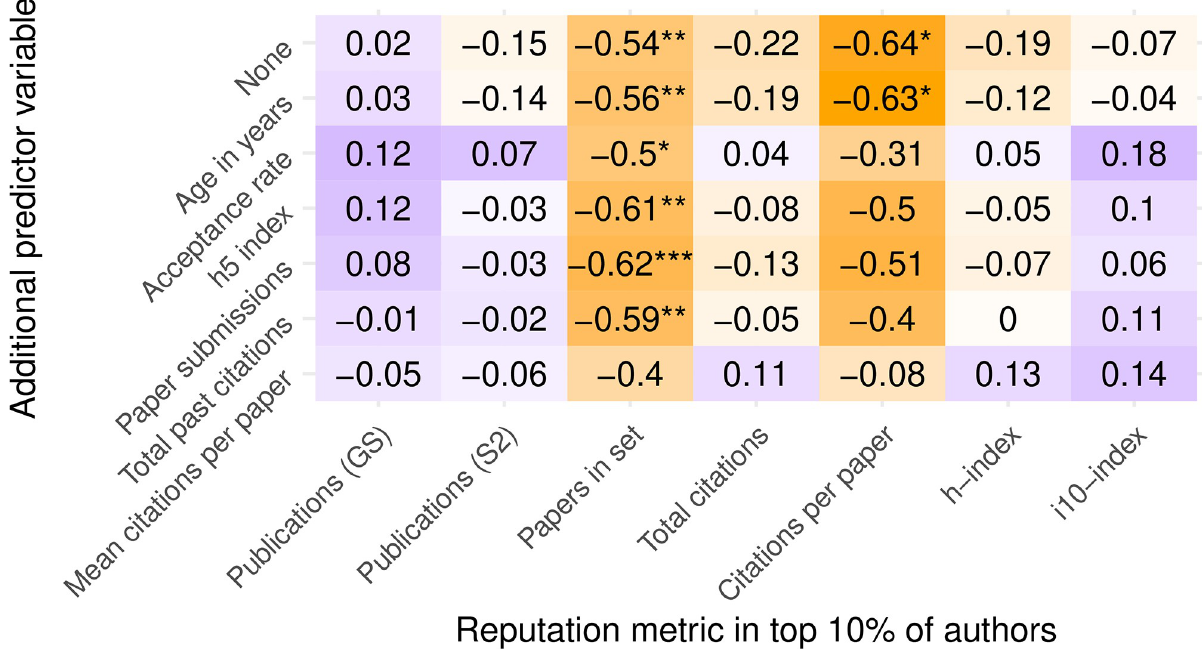
Fig 11. Mixed effects logistic regression of the top decile of various author prestige metrics as predicted by review policy and other conference variables with conference as a random effect. Values shown are the coefficient of DB reviewing in the logistic model and their associated p-values, estimated via Satterthwaite’s degrees of freedom method [30]. Positive coefficients (purple) indicate higher reputation in SB conferences. Negative coefficients (orange) indicate higher reputation in DB conferences. Darker colors reflect larger-magnitude values. Stars indicate p values below 0.05, 0.01, and 0.001,